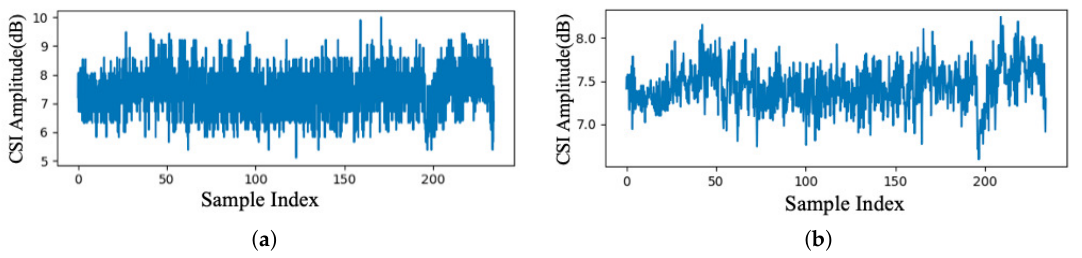
Figure 3. Result of low-pass filtering: ( a ) raw amplitude measurement, and ( a ) amplitude after low-pass filter. We describe the CSI derived from pre-processing block as (cid:103) CSI ( t ) , which includes the low-pass filtered and calibrated amplitude/phase